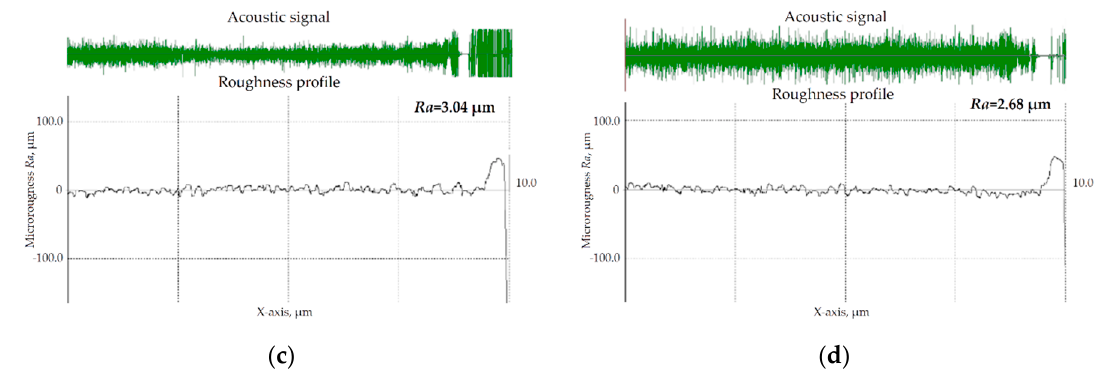
Figure 7. Roughness R a and recorded signal amplitude: ( a ) 12Kh18N10T (AISI 321) steel of 24.5 g, R a of 2.00 µm , V 0 = 55 V; W t = 35 N; ( b ) 12Kh18N10T (AISI 321) steel of 4.3 g, R a of 1.89 µm , V 0 = 55 V; W t = 35 N; ( c ) D16 (AA2024) alloy of 10.7 g, R a of 3.04 µm , V 0 = 60 V; W t = 35 N; ( d ) D16 (AA2024) alloy of 1.8 g, R a of 2.68 µ m, V 0 = 60 V; W t = 40 N.